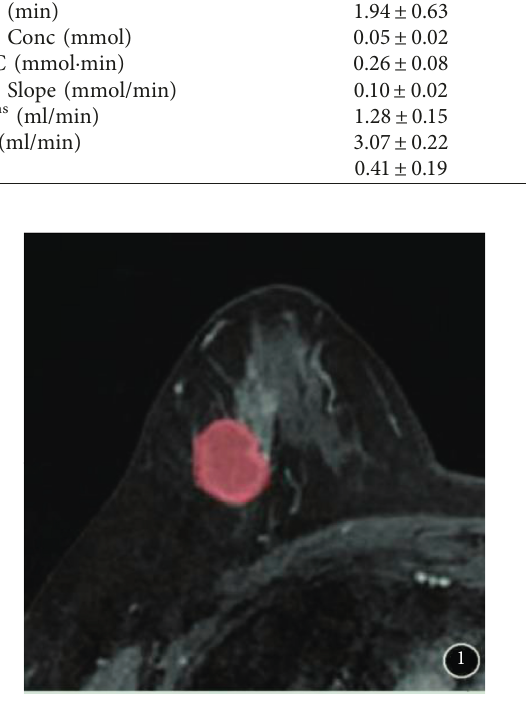
Table 2: Comparison of breast cancer recurrence and DCE-MRI hemodynamics between two groups ( n , ± s ). Indexes